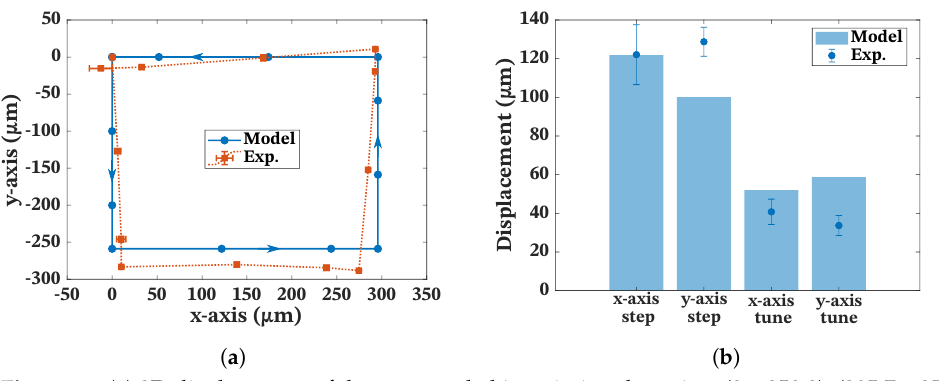
Figure 14. ( a ) 2D displacement of the conveyed object aiming the points (0, − 258.8), (295.7, − 258.8), (295.7,0), (0,0) [values in µm] following the developed A* trajectory algorithm result. ( b ) Theoretical- experimental comparison for the rectangular trajectory decomposed in displacement step and correc- tion steps for each axis.